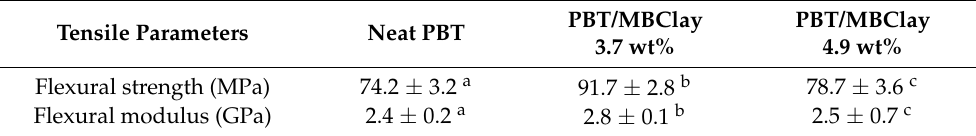
Table 5. Flexural test results for the neat PBT and PBT/MBClay nanocomposites. Tensile Parameters Neat